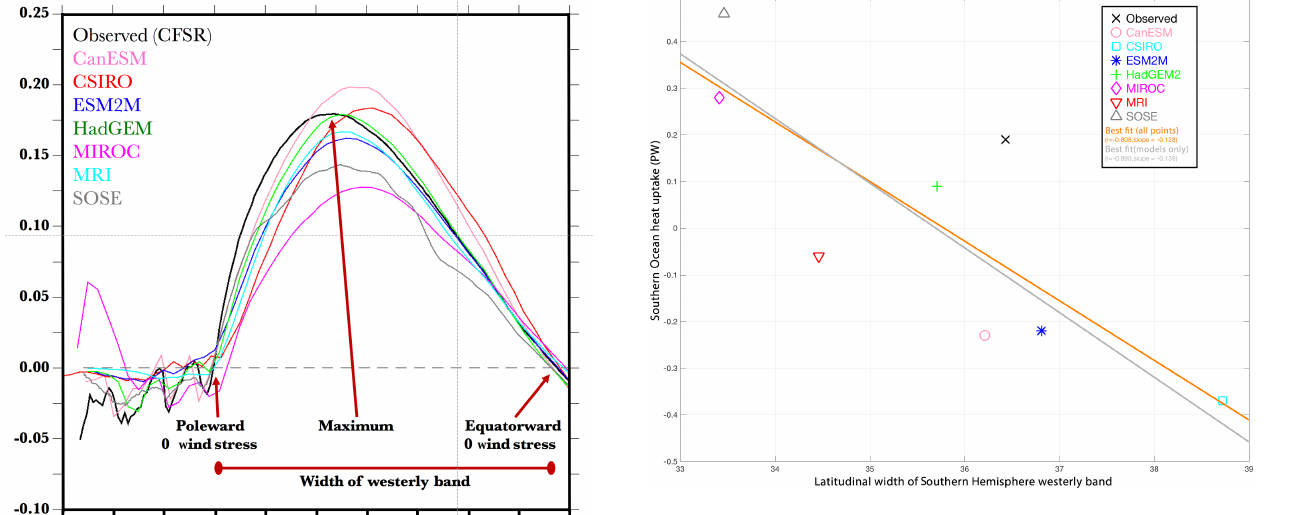
Figure 28. Scatter plot of the width of the Southern Hemisphere westerly wind band (in degrees of latitude) against the annual-mean integrated heat uptake south of 30 ◦ S (in petawatts, PW – negative uptake is heat lost from the ocean), along with the “best fit” linear relationship for the models and observations shown. Enhanced from figure produced by recipe_russell18jgr.yml ; see Sect. 3.3.2. For fur- ther discussion of this figure, see the original in Russell et al. (2018). The calculation of the “observed” heat flux into the Southern Ocean is described in the text. The correlation is significant above the 98% level based on a simple t